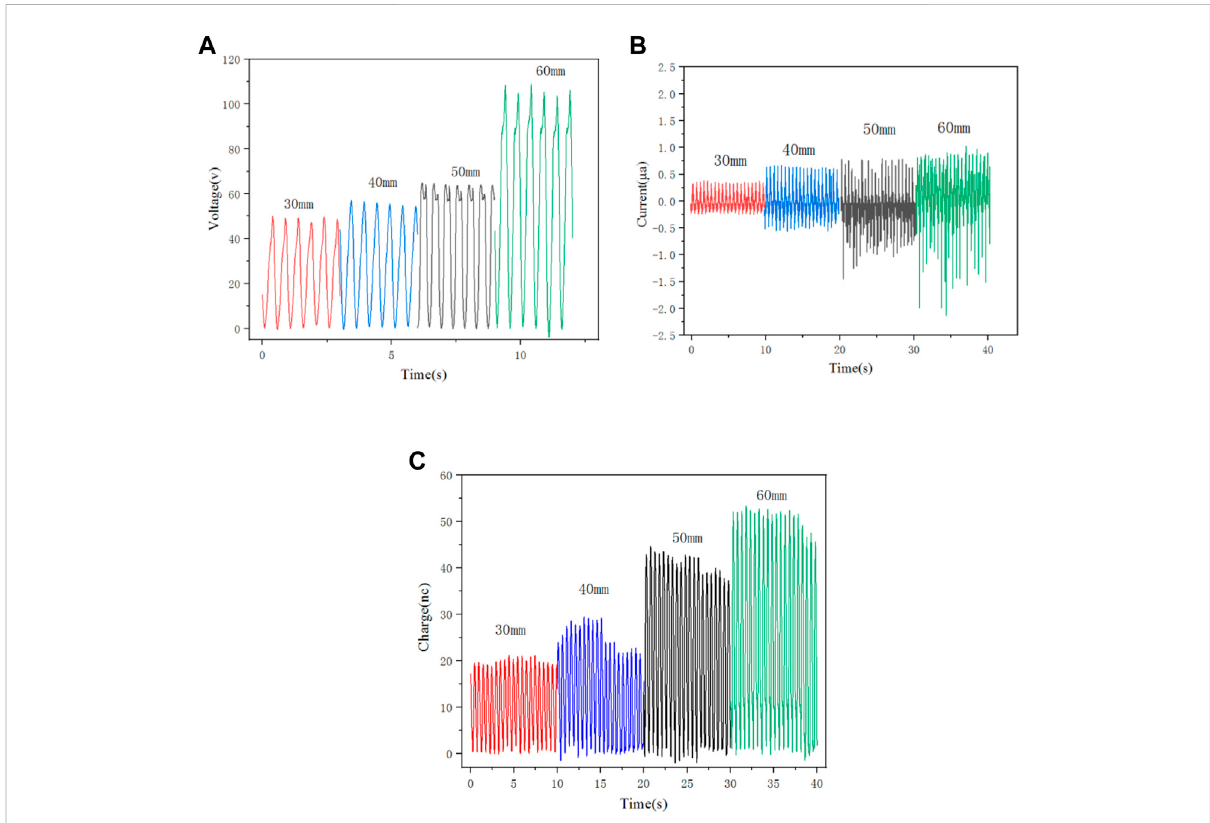
FIGURE 10 Outputperformanceatthesamefrequencyanddifferentamplitudes. (A) Open-circuit voltage; (B) Short-circuitcurrent; (C)